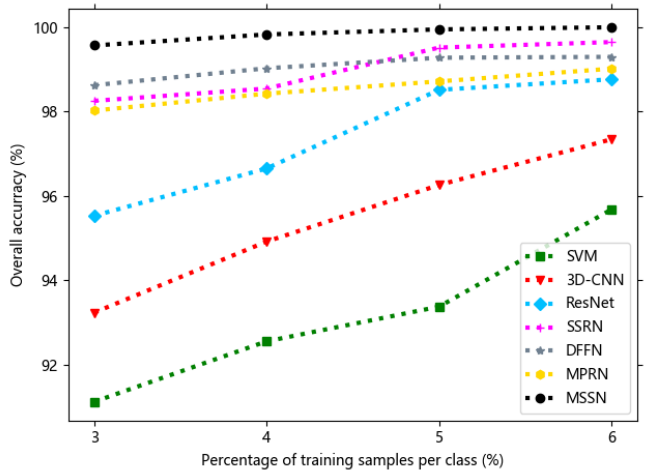
Figure 12. Overall classi fi cation accuracies obtained by different methods when considering different percentages of training samples on the Pavia University data set.